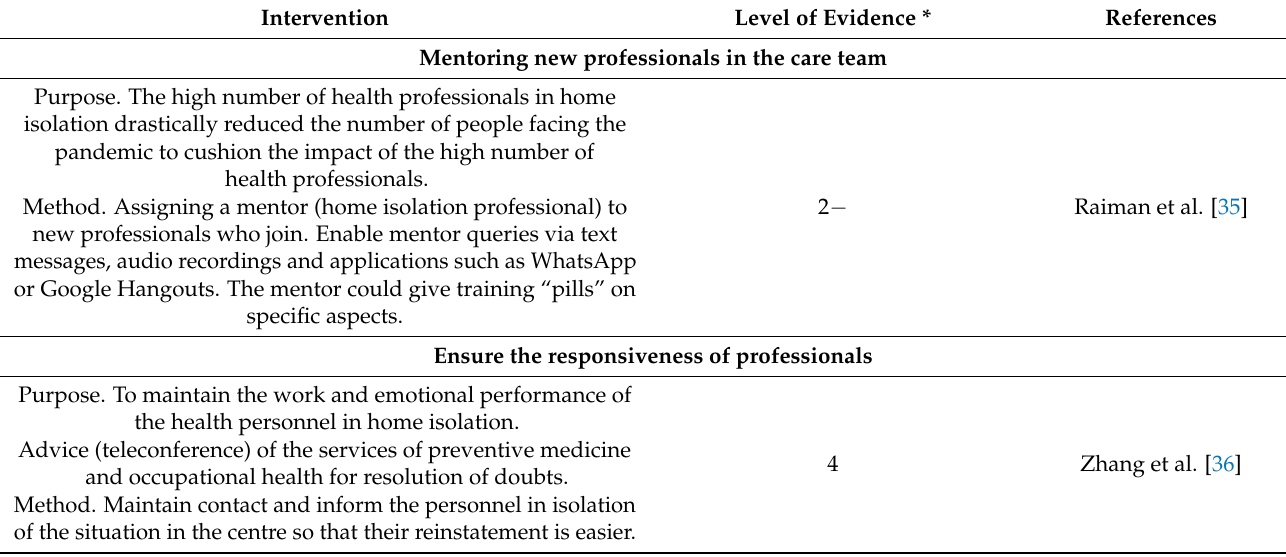
Table 3. Interventions aimed at better equipping isolated personnel to be of service. Intervention